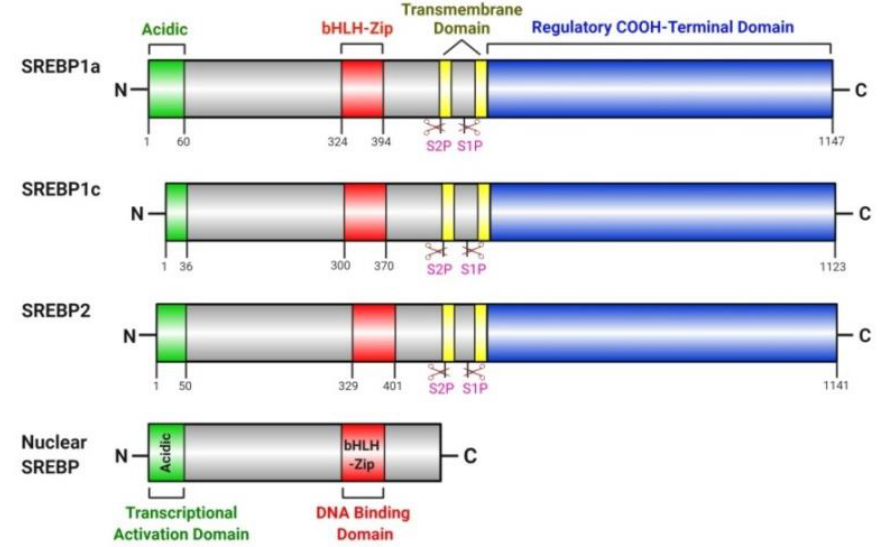
Figure 2. Domain structure of human sterol regulatory element binding proteins (SREBPs). Each SREBP precursor (SREBP1a, SREBP1c and SREBP2) shares a similar hairpin-like structure containing about 1150 amino acids (~125 KDa) and is organized into three domains: (1) an NH2-terminal cytoplasmic domain helix-loop-helix-leucine zipper (bHLH-Zip) DNA binding domain; (2) a central hydrophobic region